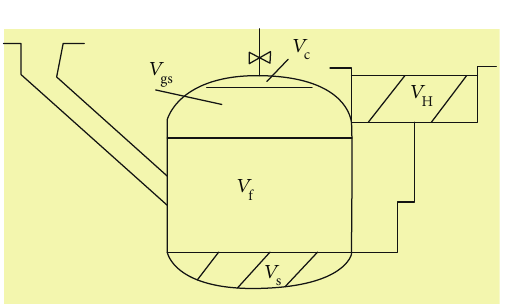
Figure 5: Biogas digester geometry con fi guration [2].